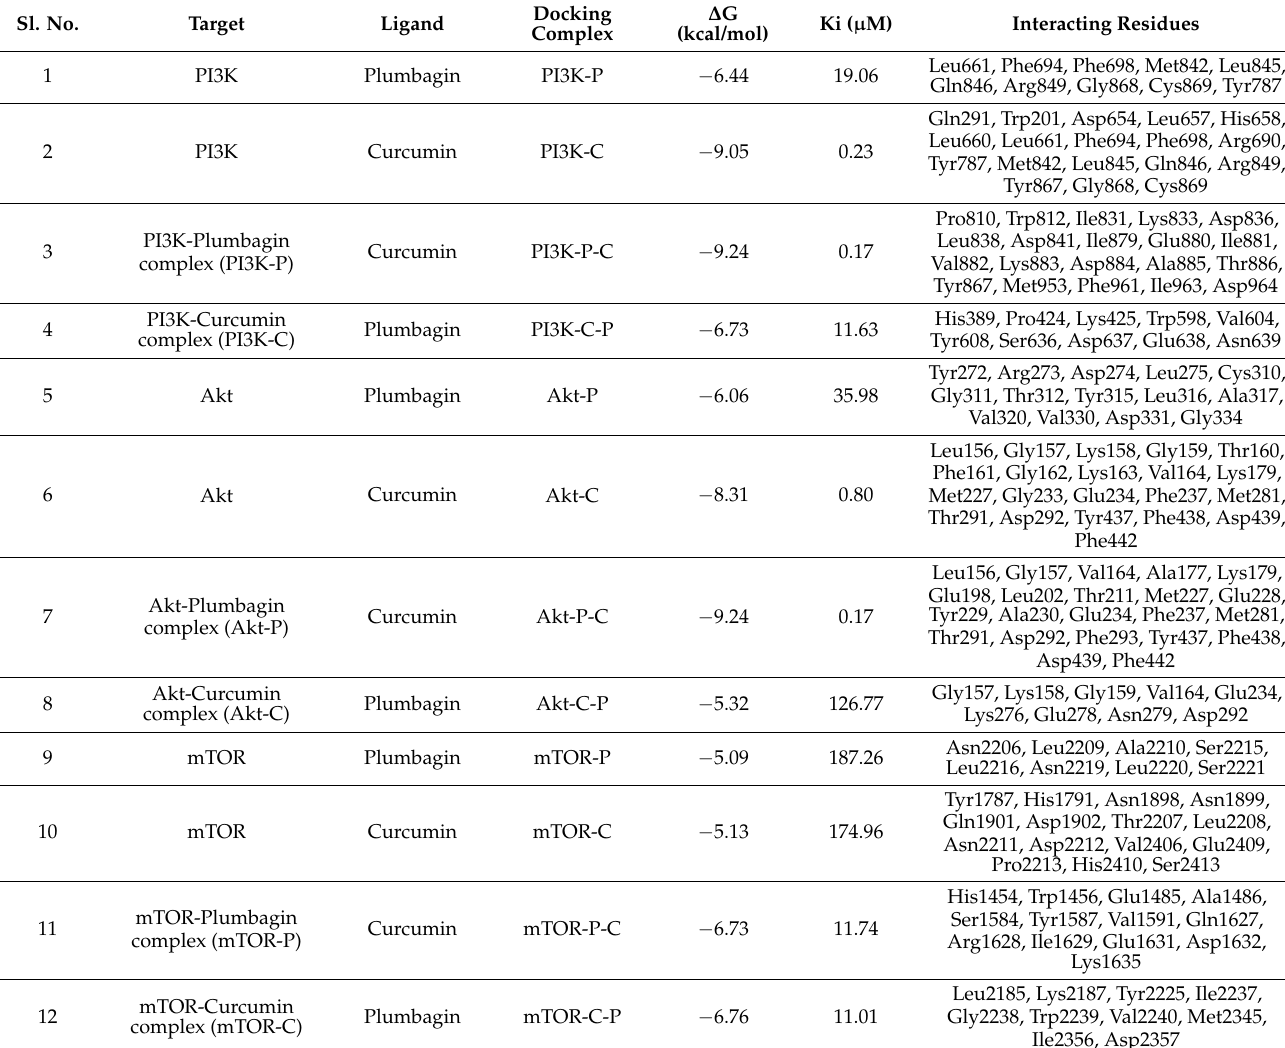
Table 1. The binding energy ( ∆ G), inhibition constant (Ki), and molecular interactions of plumbagin and curcumin sequentially docked against PI3K, Akt, and